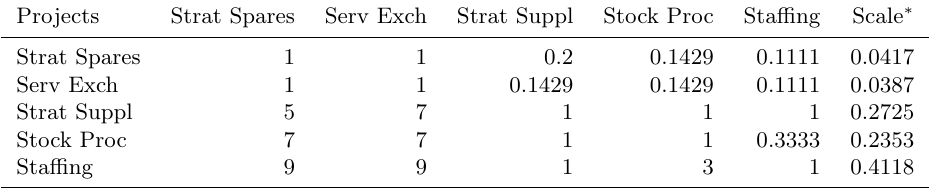
Pairwise comparison matrix and scale for ‘External’ factor. *The scale (eigenvector) is normalised to sum to one. Here λ max = 5.1347, CI = 0.0337, RI = 1.12, CR = 0.03.